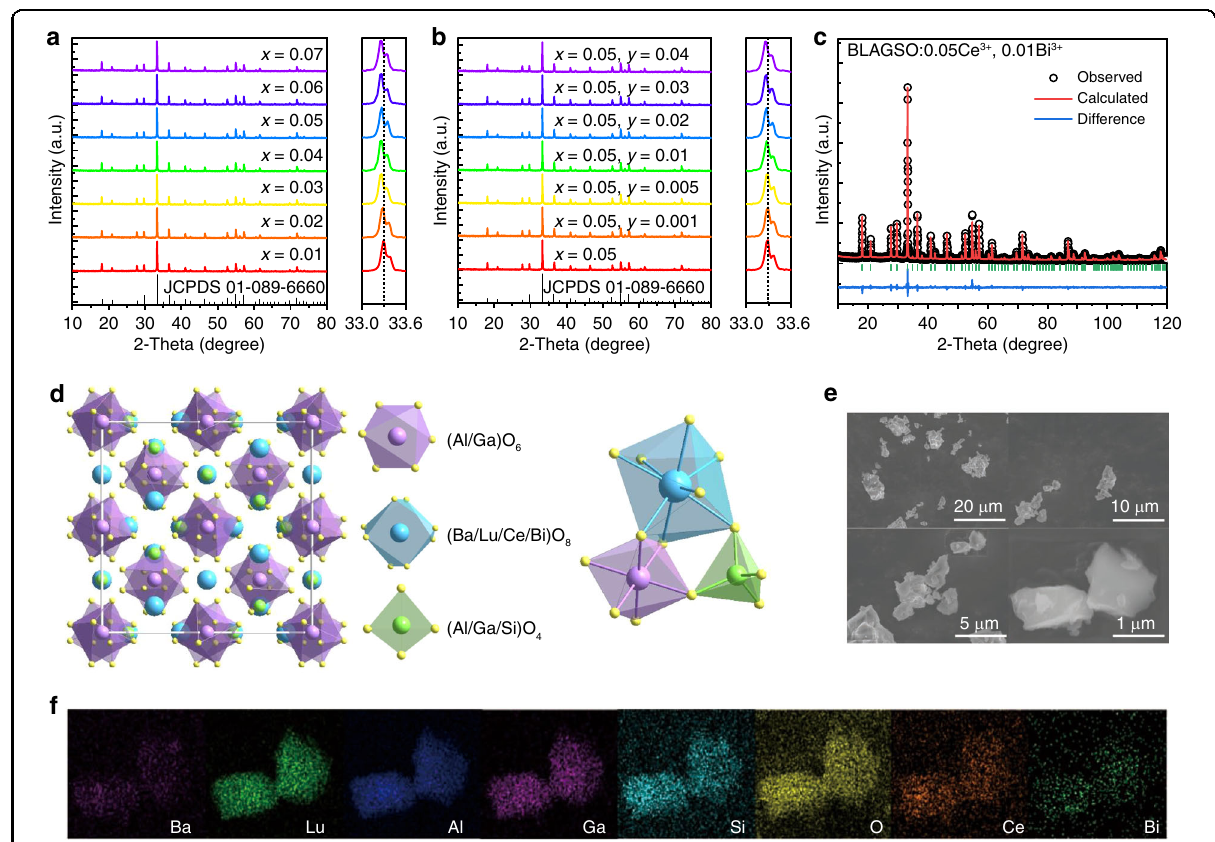
Fig. 1 Crystal structure and micromorphology. a XRD patterns of BLAGSO: x Ce 3 + . b XRD patterns of BLAGSO:0.05Ce 3 + , y Bi 3 + . c XRD Rietveld re fi nement for BLAGSO:0.05Ce 3 + , 0.01Bi 3 + . d Crystal structure. e SEM of BLAGSO:0.05Ce 3 + , 0.01Bi 3 + . f Elemental mapping of BLAGSO:0.05Ce 3 + , 0.01Bi 3